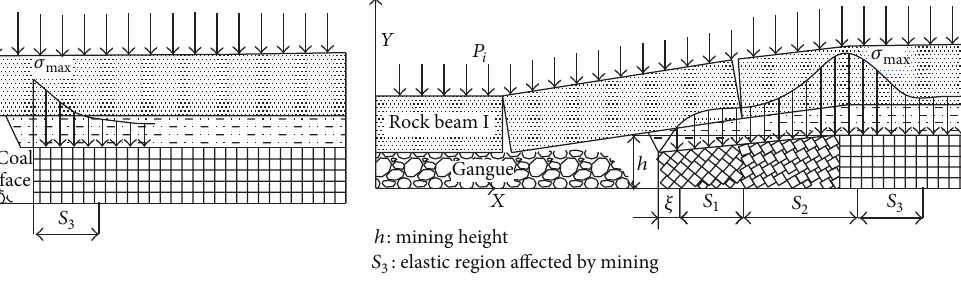
Figure 9: The coal body failure model.